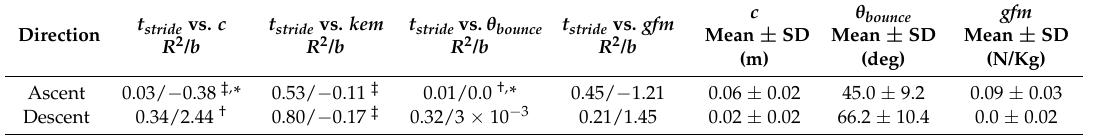
Table 2. Kinematic and kinetic variables for running while ascending and descending stairs.